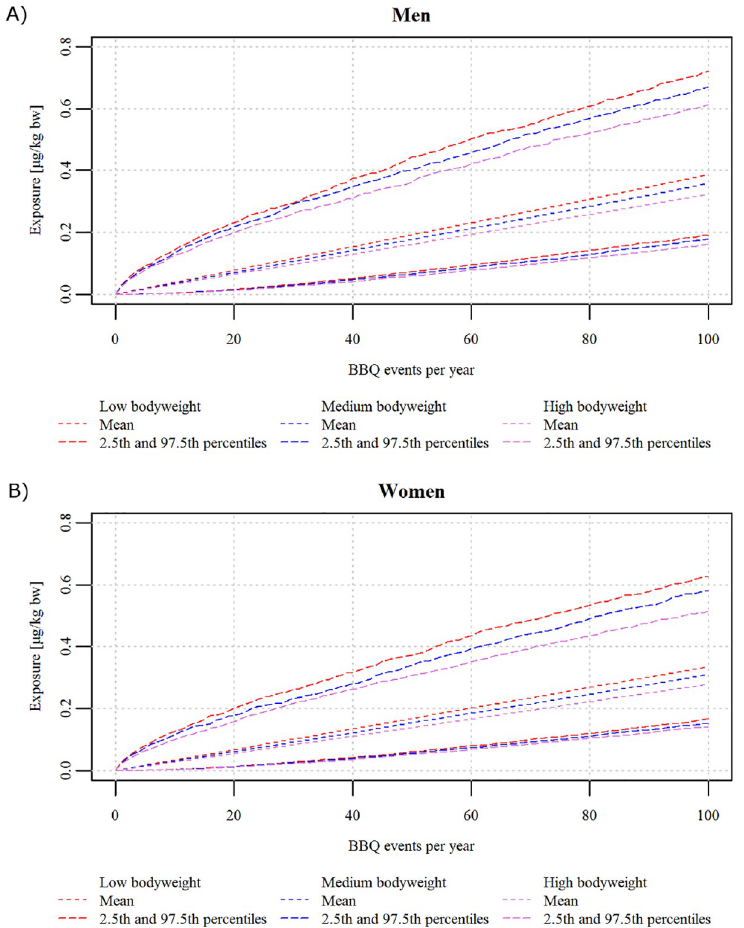
Fig 5. Exposure to benzo[ a ]pyrene (in μ g/kgbodyweight/year) as a function of events of consuming barbecued meat per year. A: Men, B: Women. Mean, 2.5 th and 97.5 th percentiles of the exposure simulated for 5,000 individuals per subgroup and per number of events from 1 to 100 per